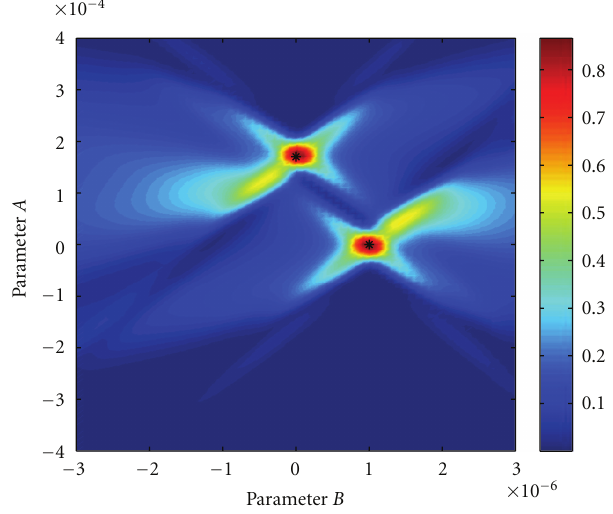
Figure 7: Uncorrelated sources: Determination of parameters A and B based on semblance for a di ff ractor and a dipping reflector β = 20 0 . The black stars show the correct parameter locations.